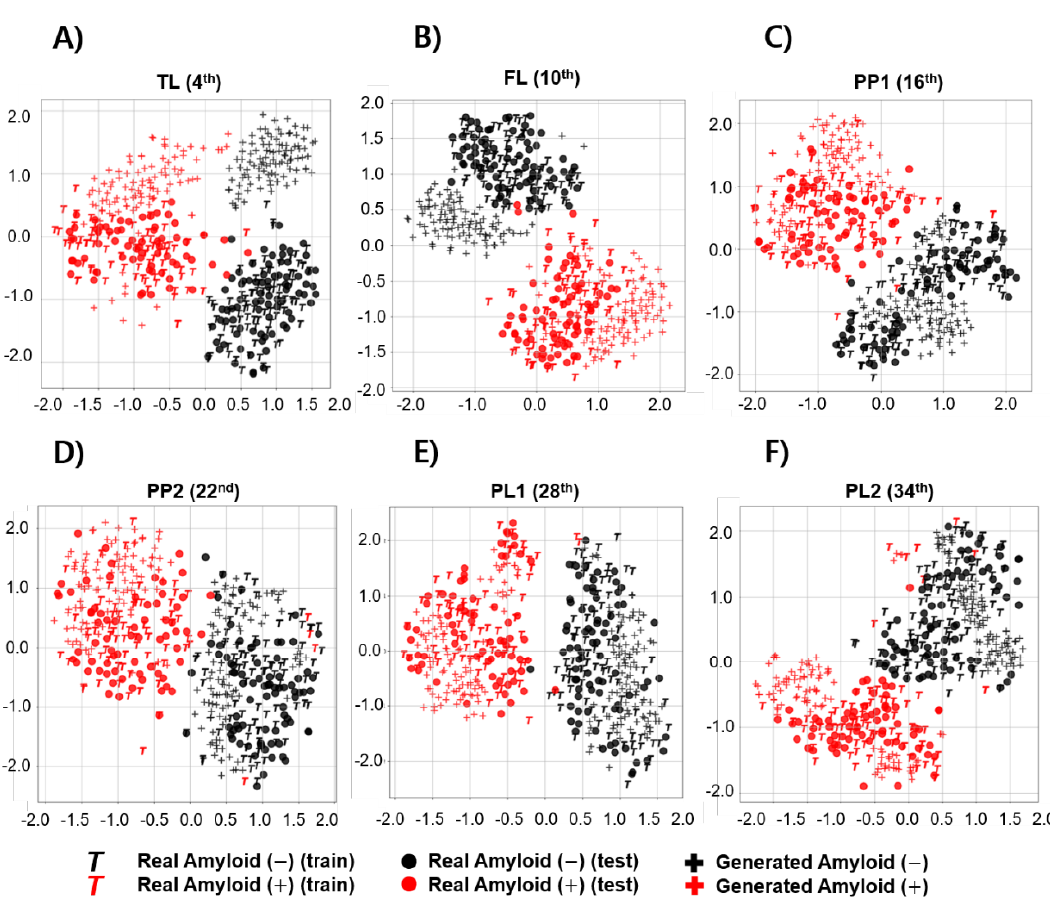
Figure 6. Feature visualization comparing the distribution between real and generated images according to brain amyloid distribution using t-SNE. Each scatter plot represents feature visualization according to a representative axial level including ( A ) temporal lobe (TL), ( B ) frontal lobe (FL), ( C ) posterior cingulate / precuneus 1 (PP1), ( D ) posterior cingulate / precuneus 2 (PP2), ( E ) parietal lobe 1 (PL1) and ( F ) parietal lobe 2 (PL2).